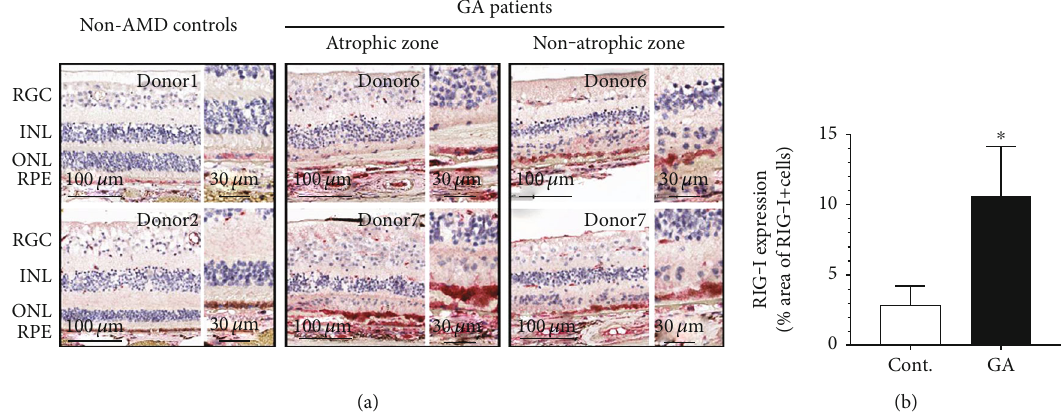
Figure 5: The RIG-I protein is expressed in human RPE, and elevated in patients with GA. (a) The expression of the RIG-I protein in non- AMD control and patients with GA was measured using IHC. Note that, unlike mRNA, RIG-I protein (red) was mainly enriched in RPE and choroid. The IgG control was used as negative control (see Supplementary Figure 1C). Examples of region selection for IHC and RNAscope from donor 6 (patient with GA) are shown in Supplementary Figure 4. In addition, the RIG-I signal in the macular region was analyzed by HALO, with the % area of RIG-I positive signals being shown in (b). Representative pictures of RIG-I IHC for each donor are shown in Supplementary Figure 5. Scale bars are indicated. n = 5/group , and patient information is listed in Supplementary Table 1. ∗ p < 0 : 05 compared with non-AMD control